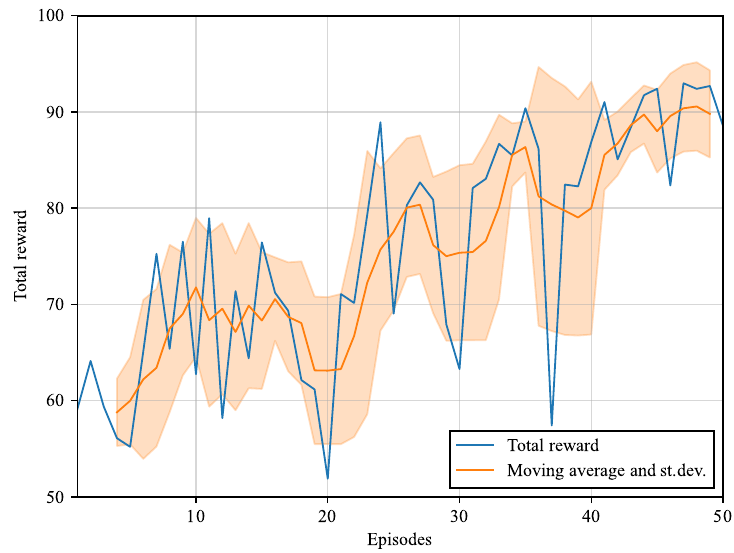
Figure 13. Rewards of the finite difference environment. Cumulative reward vs. no. of episodes; moving average and interval of range ± one standard deviation for the last ten episodes (orange